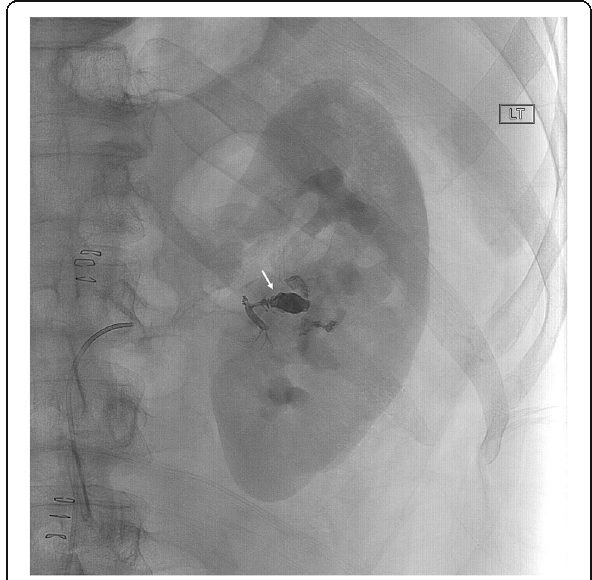
Fig. 4 53 year-old male presented with hematuria after left partial nephrectomy. Fluoroscopic image demonstrates successful EVOH (Onyx 34) embolization of afferent, efferent vessel and sac of the PSA (arrow), arising from a third order branch of a left renal